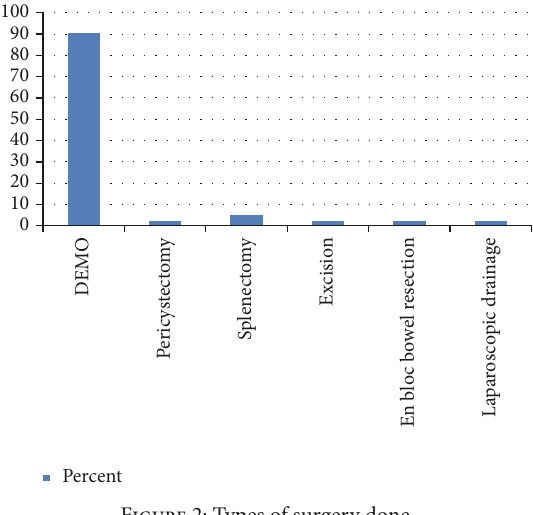
Figure 2: Types of surgery